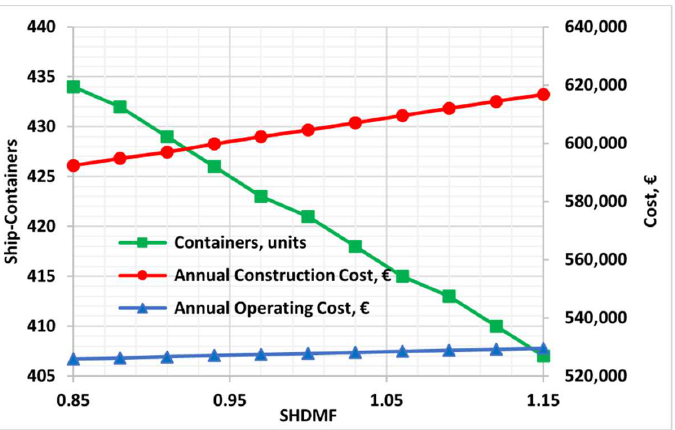
Figure 9. Transported containers, ship annual operating and construction costs.